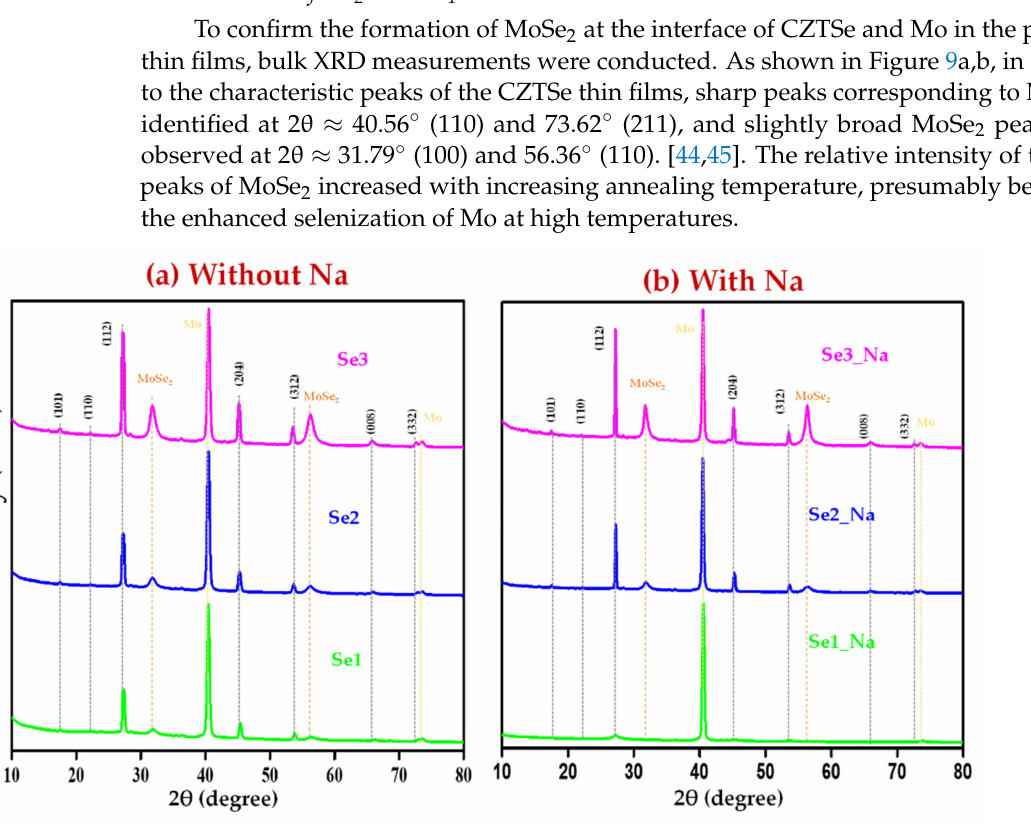
Figure 9. Bulk XRD patterns of CZTSe thin films ( a ) without and ( b ) with sodium